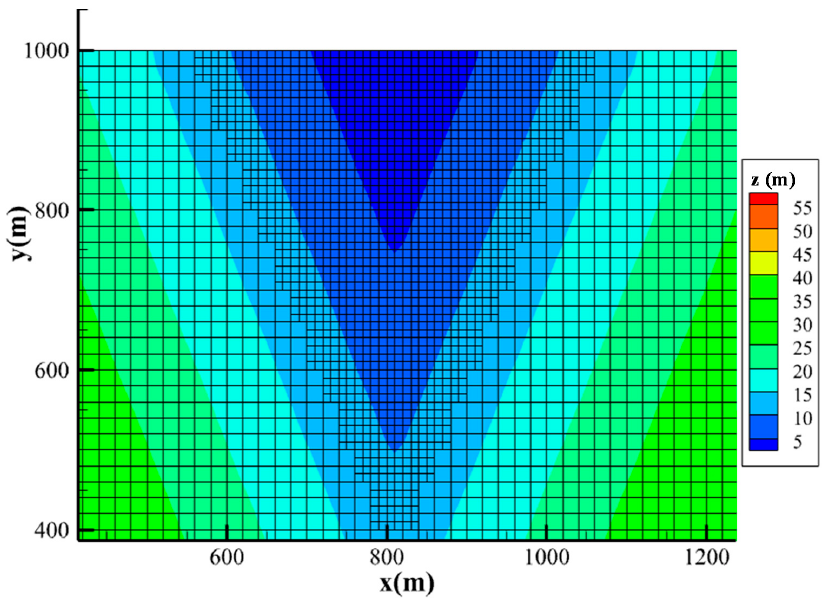
Figure 12. The gird partition of the V-shaped catchment (local computational domain).